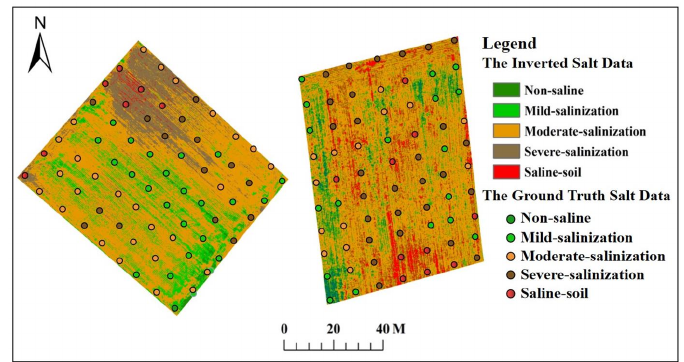
Figure 4. Inversion results and ground measurement of soil salinity in test areas A and B.